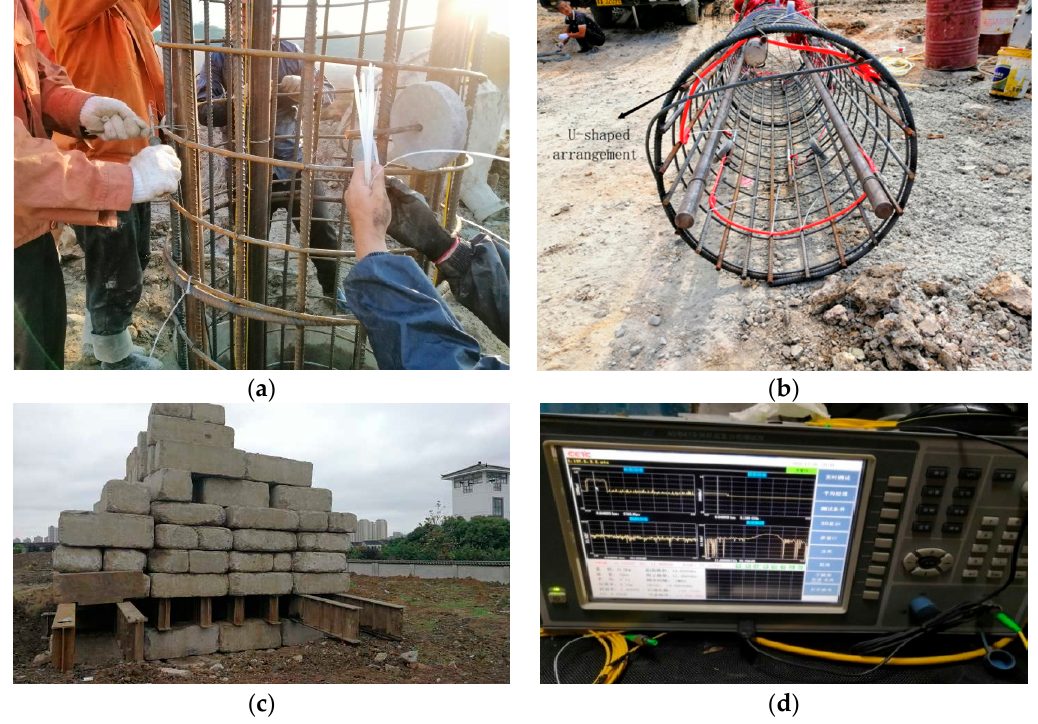
Figure 2. Photos of field test. ( a ) Fixing optical fiber; ( b ) U-shaped wiring; ( c ) Field loading; ( d ) BOTDR instrument.